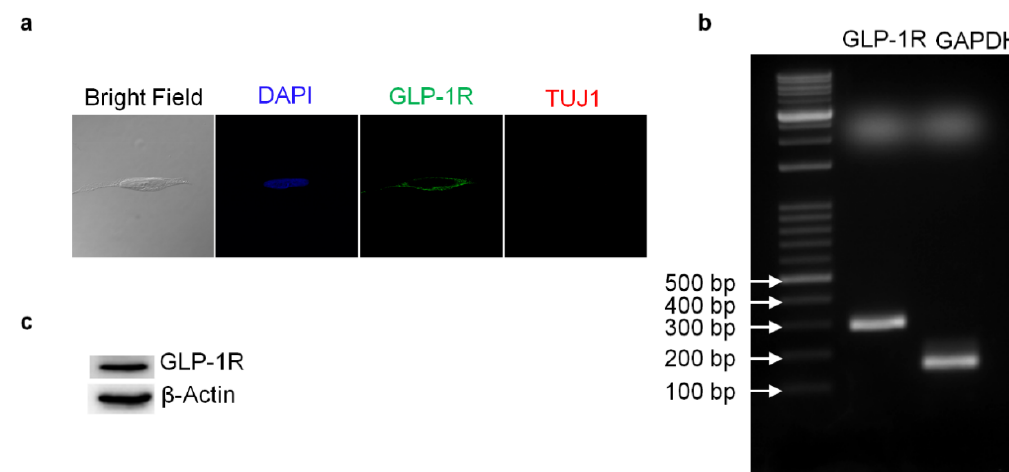
Figure 1. GLP-1 receptor expression detected in the human neuroblastoma SH-SY5Y cells. The confocal images of immunofluorescent staining revealed that SH-SY5Y cells express GLP-1 receptors (GLP-1Rs) which are mainly distributed in cell membrane areas. In addition, the neuron marker Tuj1 (neuron-specific class III beta-tubulin) was slightly expressed in neuroblastoma cells ( a ). The agarose gel electrophoresis image reflecting the reverse transcription-PCR results demonstrated that the mRNA of GLP-1R was expressed in SH-SY5Y cells ( b ). The Western blotting results confirmed that GLP-1Rs were expressed in human neuroblastoma SH-SY5Y cells as well ( c ).